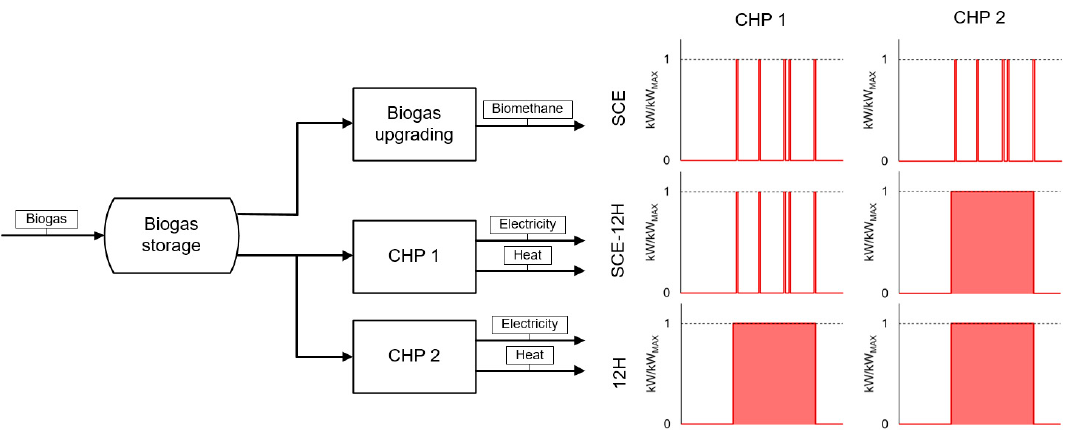
Figure 2. Left: Flowsheet of developed process simulation model; Right: Investigated scenarios for power generation.